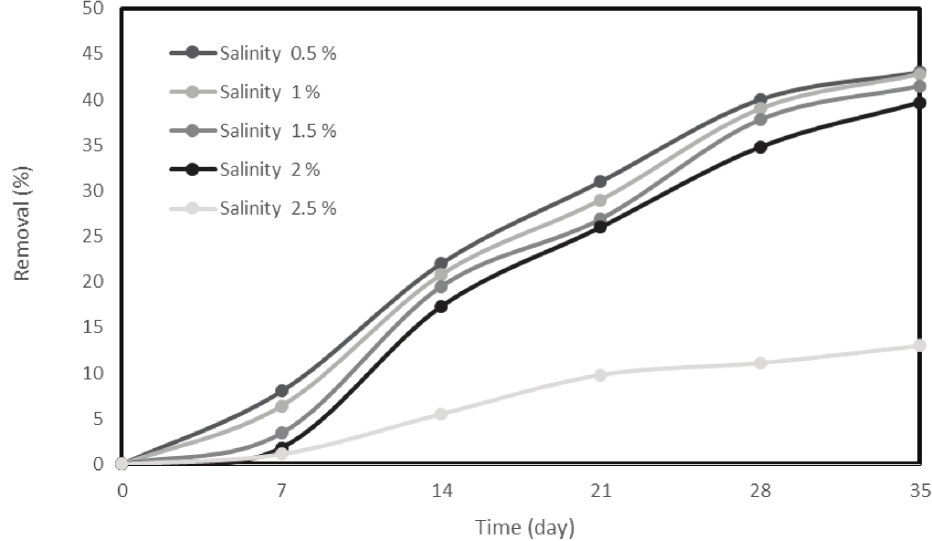
Fig. 6 – Effect of salinity on biodegradation rate of n-hexadecane in synthetically contaminated soil, seed volume: 15 mL, moisture: slurry, and surfactant: